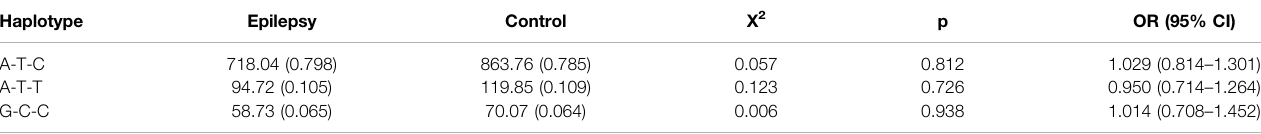
TABLE 6 | Association between Haplotypes of STX1B SNPs and epilepsy risk. Haplotype